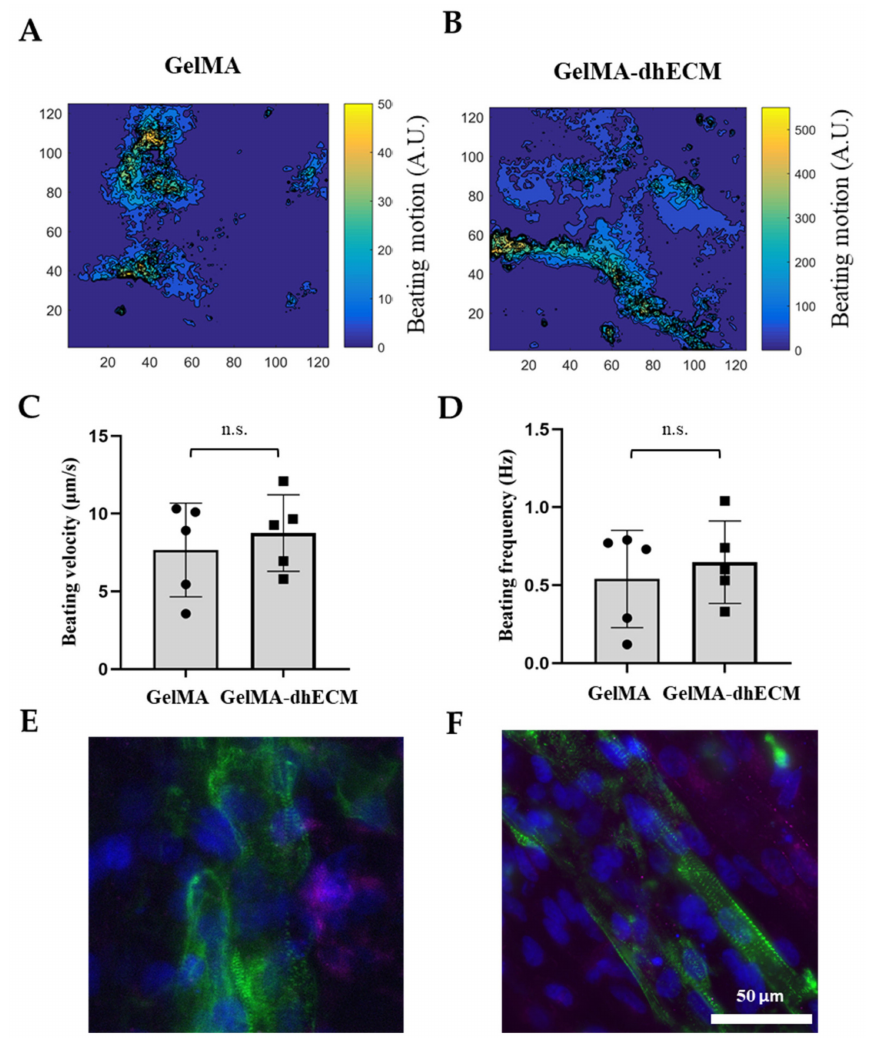
Figure 6. Beating and phenotypical characterization of iCMs. The heat maps showing the beating velocity magnitude (A.U.) and distribution of iCM ( A ) when they were printed in GelMA hydrogel, ( B ) when they were printed in the GelMA–dhECM hydrogel, ( C ) average beating velocity of iCMs, ( D ) average beating frequency of iCMs. Immunostaining of iCMs for CX43 (magenta) and sarcomeric alpha-actinin (green), ( E ) when they were printed in GelMA hydrogel, and ( F ) when they were printed in the GelMA–dhECM hydrogel. Cell nuclei are stained with DAPI (blue) (n.s.: not significant) (Student’s t -test) ( n ≥